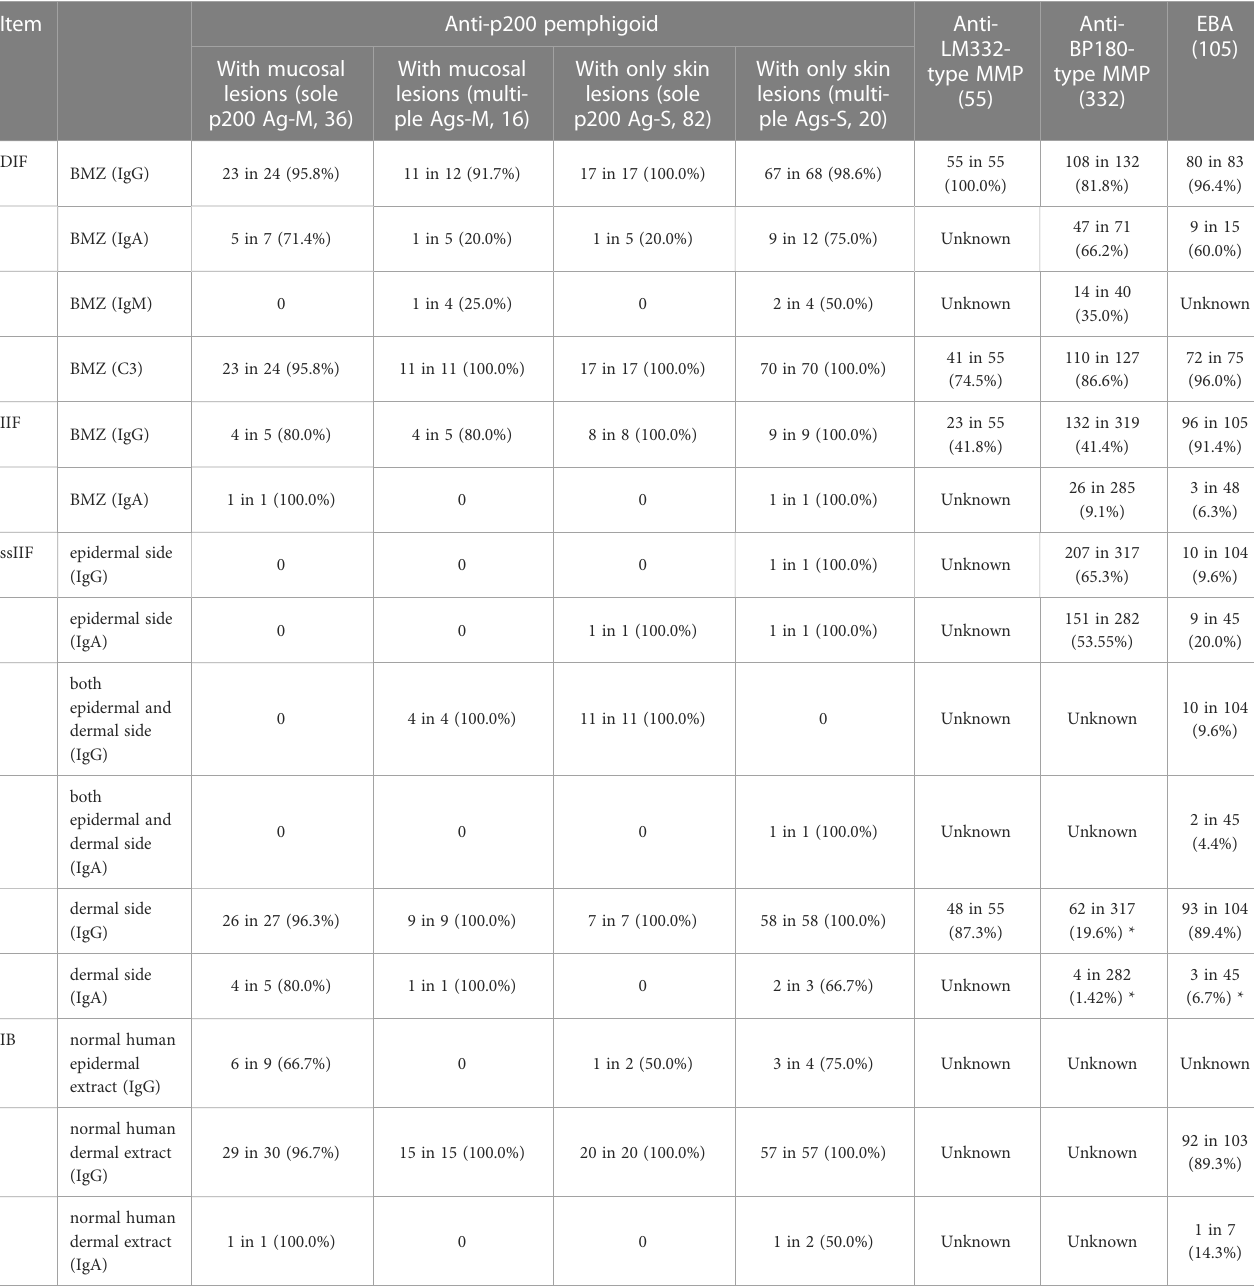
TABLE 5 Comparison of immunological features between anti-p200 pemphigoid with mucosal lesions and other AIBD subtypes.